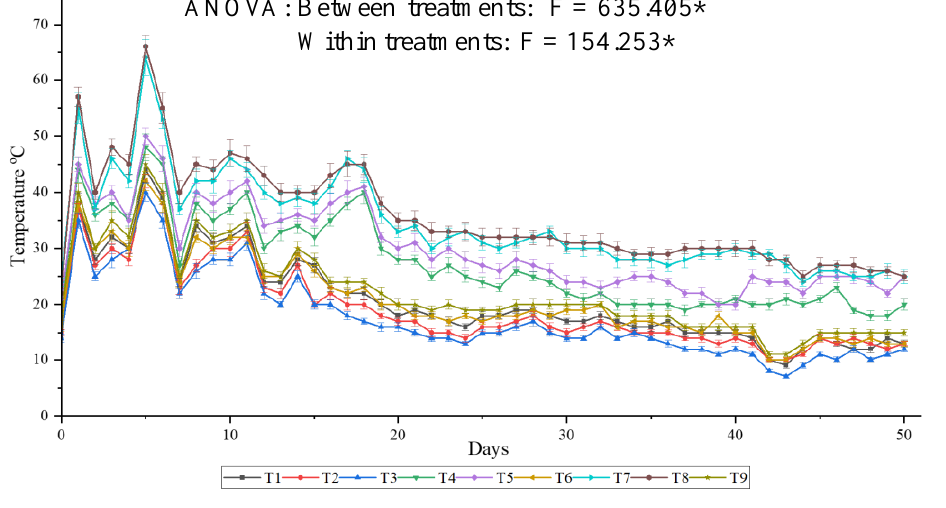
Figure 1. Dynamics of temperature among various composting treatment groups. ‘*’ indicates a significant difference at p < 0.05 by ANOVA.